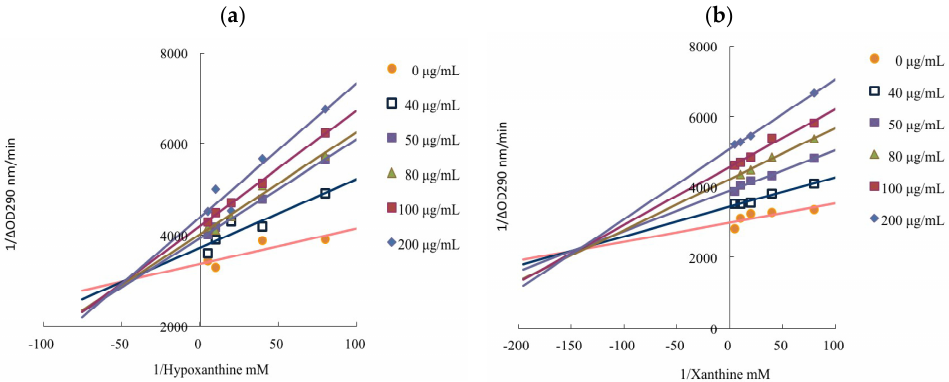
Figure 4. Lineweaver–Burk plots of limonene: ( a ) hypoxanthine as the substrate; ( b ) xanthine as the substrate. Table 6. Kinetic parameters of limonene against xanthine oxidase in enzyme kinetic study.